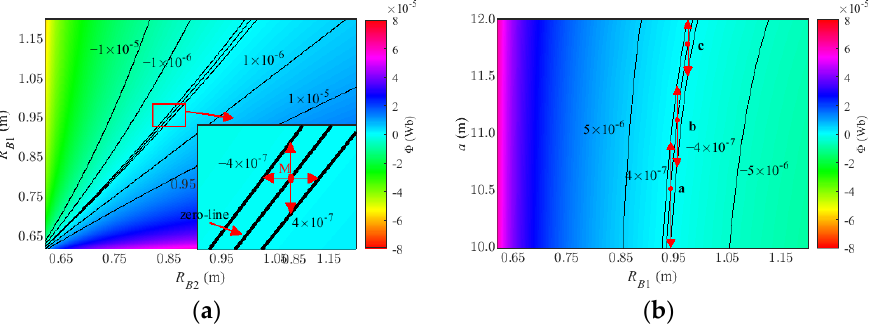
Figure 6. Field calculation results: ( a ) the influence of the inter bucking coil radius R B2 and the outer bucking coil radius R B1 . ( b ) the influence of the receiving coil position offset a and outer bucking coil size radius R B1 .